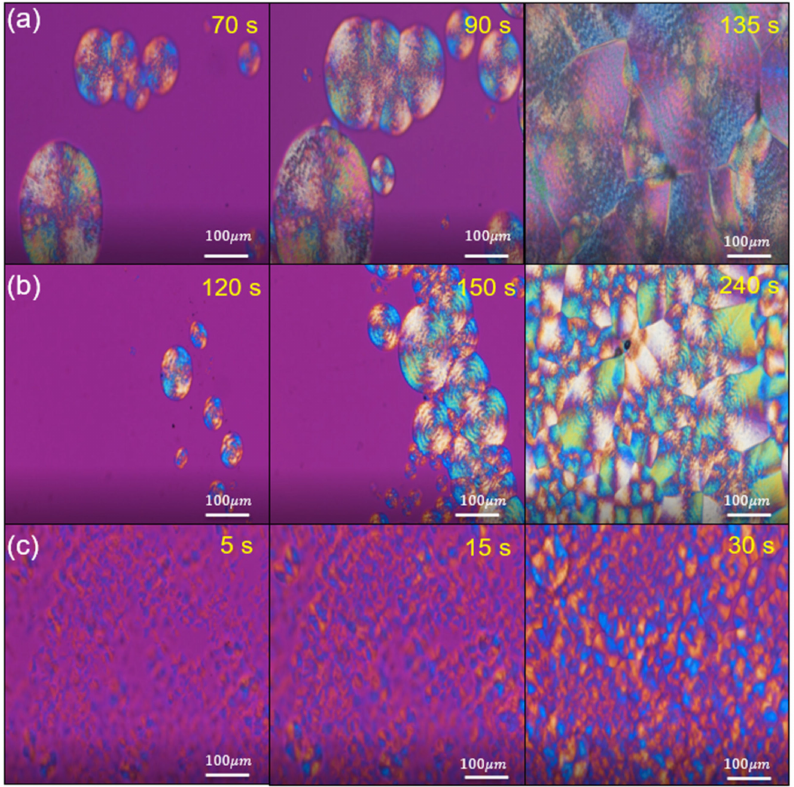
Figure 8. Optical micrographs of crystallized at different times of ( a ) PA56, ( b ) CoPA-1 and ( c )